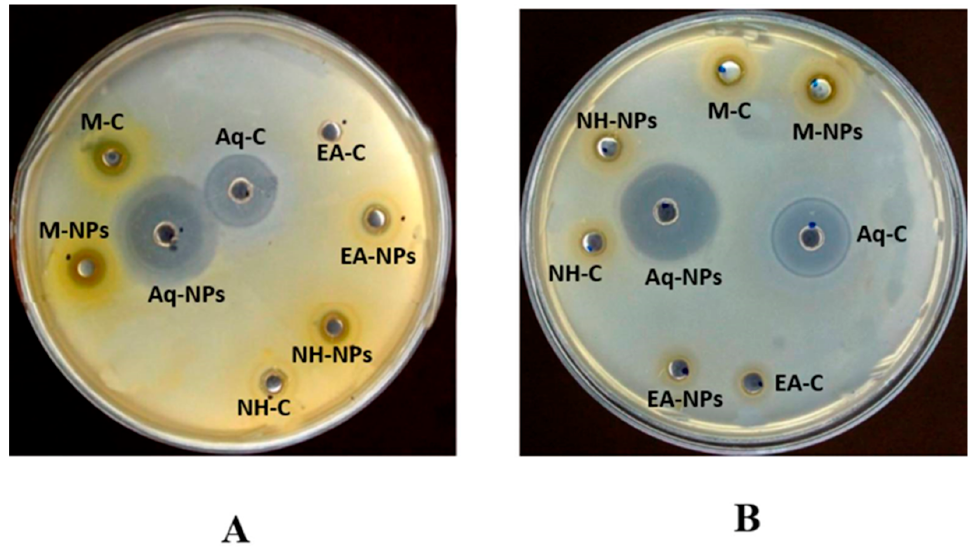
Figure 11. Anti-bacterial activity of ZnONPs and crude extracts of different solvents of C. colocynthis. ( A ) From leaves; ( B ) from fruits. AqNPs = aqueous nanoparticles; AqC = aqueous control; MNPs = methanol nanoparticles; MC = methanol control; NHNPs = n-hexane nanoparticles; NHC = n-hexane control; EANPs = ethyl acetate nanoparticles; EAC = ethyl acetate